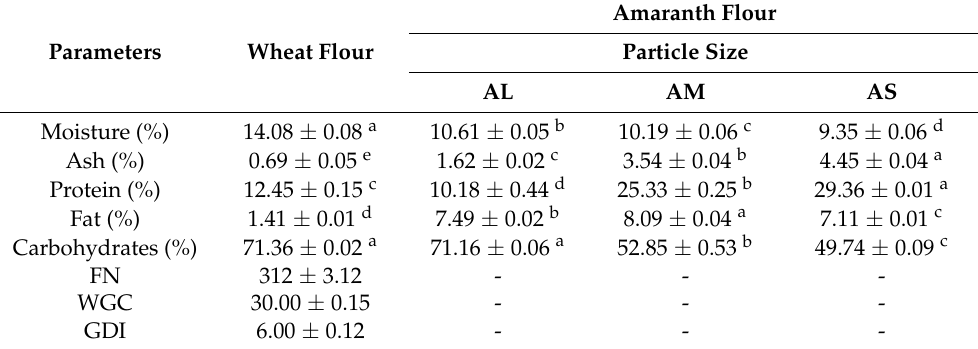
Table 2. One-way analysis of variance (ANOVA) of the chemical composition of the wheat flour in comparison with amaranth flour fractions: large particle size (AL), medium particle size (AM) and, small particle size